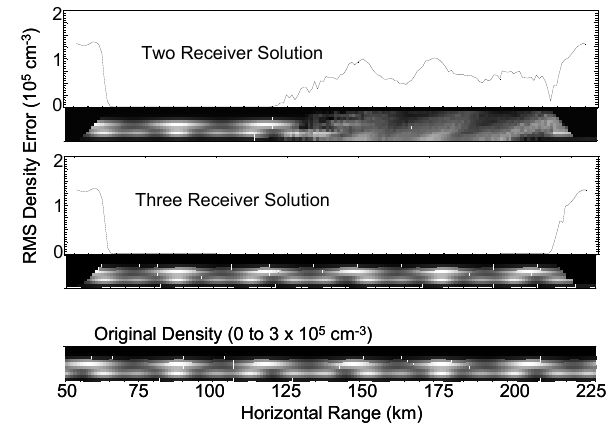
Figure 15. SVD reconstruction of the test example using data from three receivers, 1082 samples per receiver and a reconstruction grid with 1 km (H) x 1 km (V) cell size. The addition of the data from the third receiver yields the improved reconstruction region.